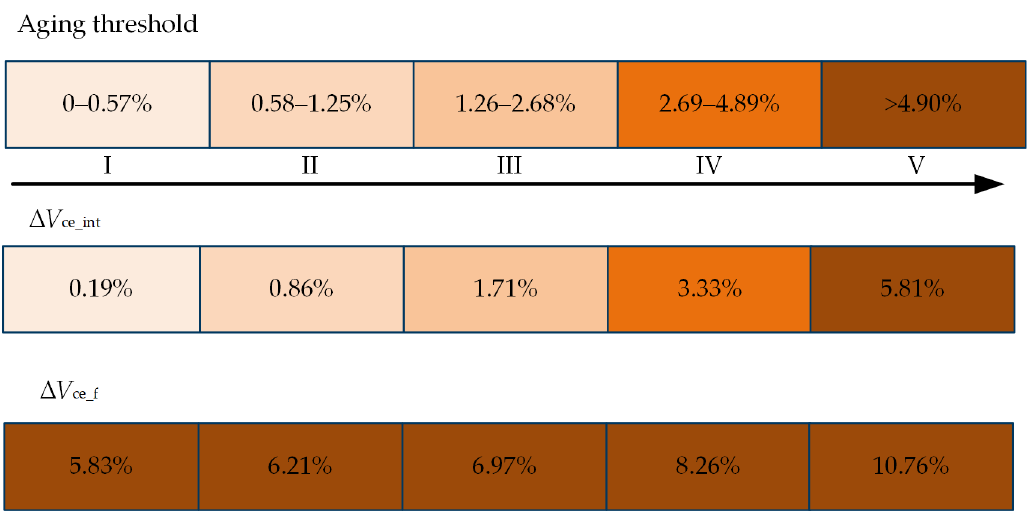
Figure 10. Comparison of aging monitoring results.